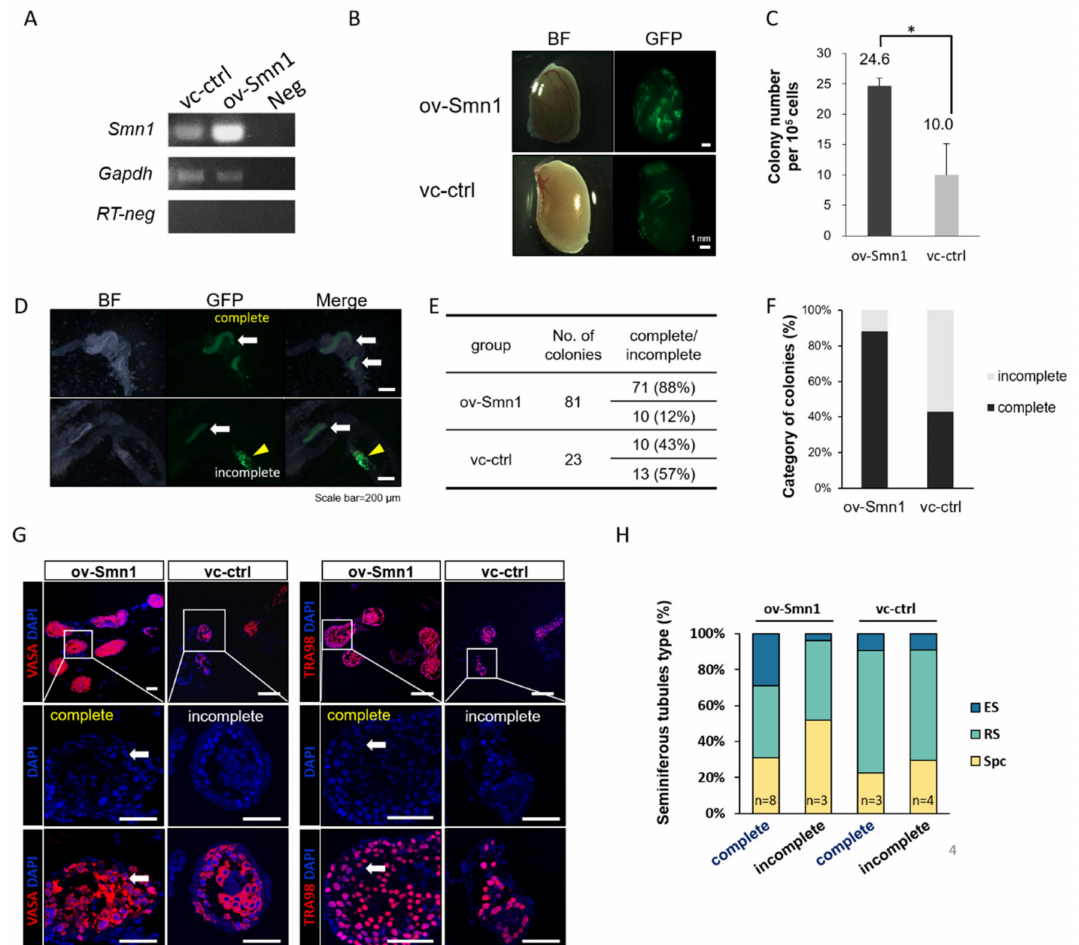
Figure 2. Overexpression of SMN1 promotes self-renewal and homing ability of mouse SSCs. ( A ) abundancy of Smn1 RNA is confirmed in Smn1 overexpressed (ov-Smn1) SSCs compared with vector control (vc-ctrl) by semi-quantitative RT-PCR. Gapdh is the internal control. RNAs without reverse transcription (RT-neg) is used as the negative control detected by Gapdh primer. Neg indicates the non-template control. ( B ) Transplant assay of GFP-SSCs injected into seminiferous tubule in busulfan treat male mice. Bright field (BF) demonstrates the morphology of transplanted testes, and the GFP panel indicates the propagated SSCs in ov-Smn1 and vc-ctrl group. ( C ) Quantification of the efficiency of SSC homing. Triplicates of the transplanted mice shows the significant differences in ov-Smn1 and vc-ctrl group. * Indicates significance, p < 0.05. ( D ) Seminiferous tubules with GFP colony shown as complete (white arrow) and incomplete (yellow arrowhead) colonies. ( E , F ) Quantification of the ratio of complete and incomplete colonies observed in ov-Smn1 and vc-ctrl group. ( G ) Cross section detecting germ cell markers VASA and TRA98 (red color) in transplanted seminiferous tubules. Complete colonies contain more matured elongated sperms as indicated (white arrow). DAPI is stained for DNA content (Blue). Scale bar: 50 µ m. ( H ) Distribution of germ cell types through spermatogenesis in transplant cells. ES: elongated sperm. RS: round spermatids. Spc: